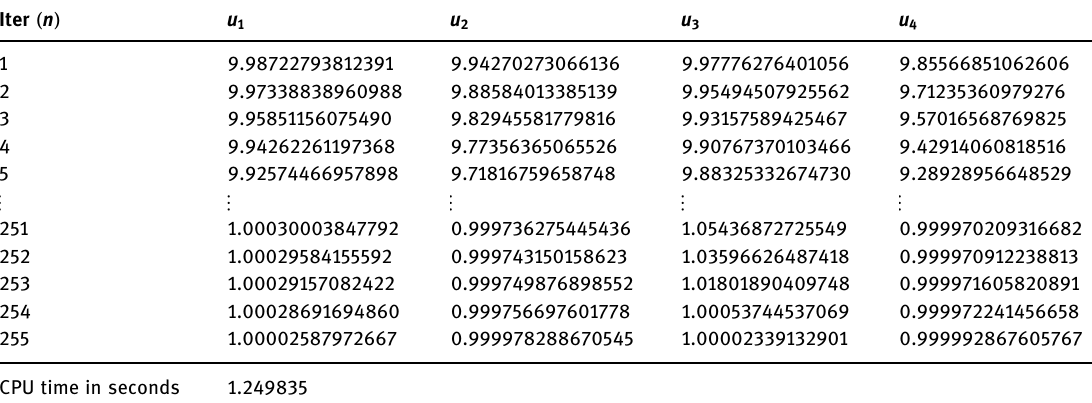
Table 3: Example 4.2: Numerical study of Algorithm 2 in [ 30 ] and